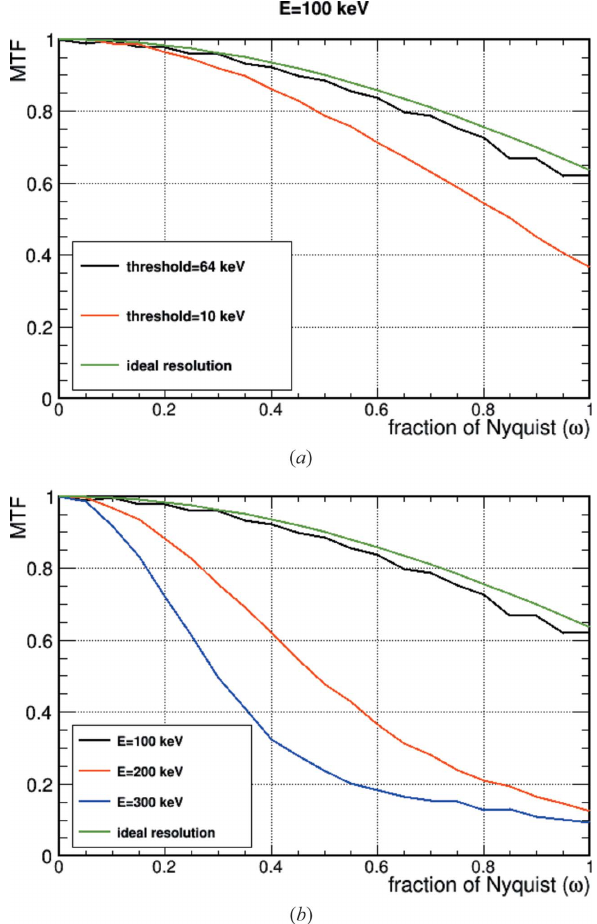
Figure 5 ( a ) MTF as a function of Nyquist frequency for 100 keV electrons. Two different threshold settings and the ideal MTF are plotted. ( b ) MTF as a function of Nyquist frequency for 100, 200 and 300 keV electrons. The best MTF at 100 keV is plotted, i.e. setting the threshold at 64 keV. For 200 and 300 keV electrons, the threshold is set to 10